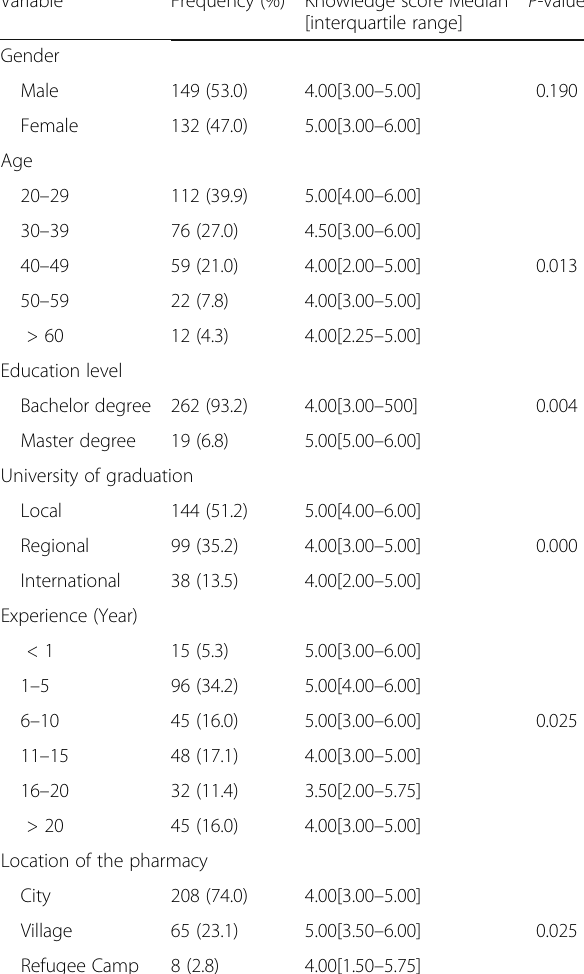
Table 5 Association between the sociodemographic and practice variables and median knowledge scores